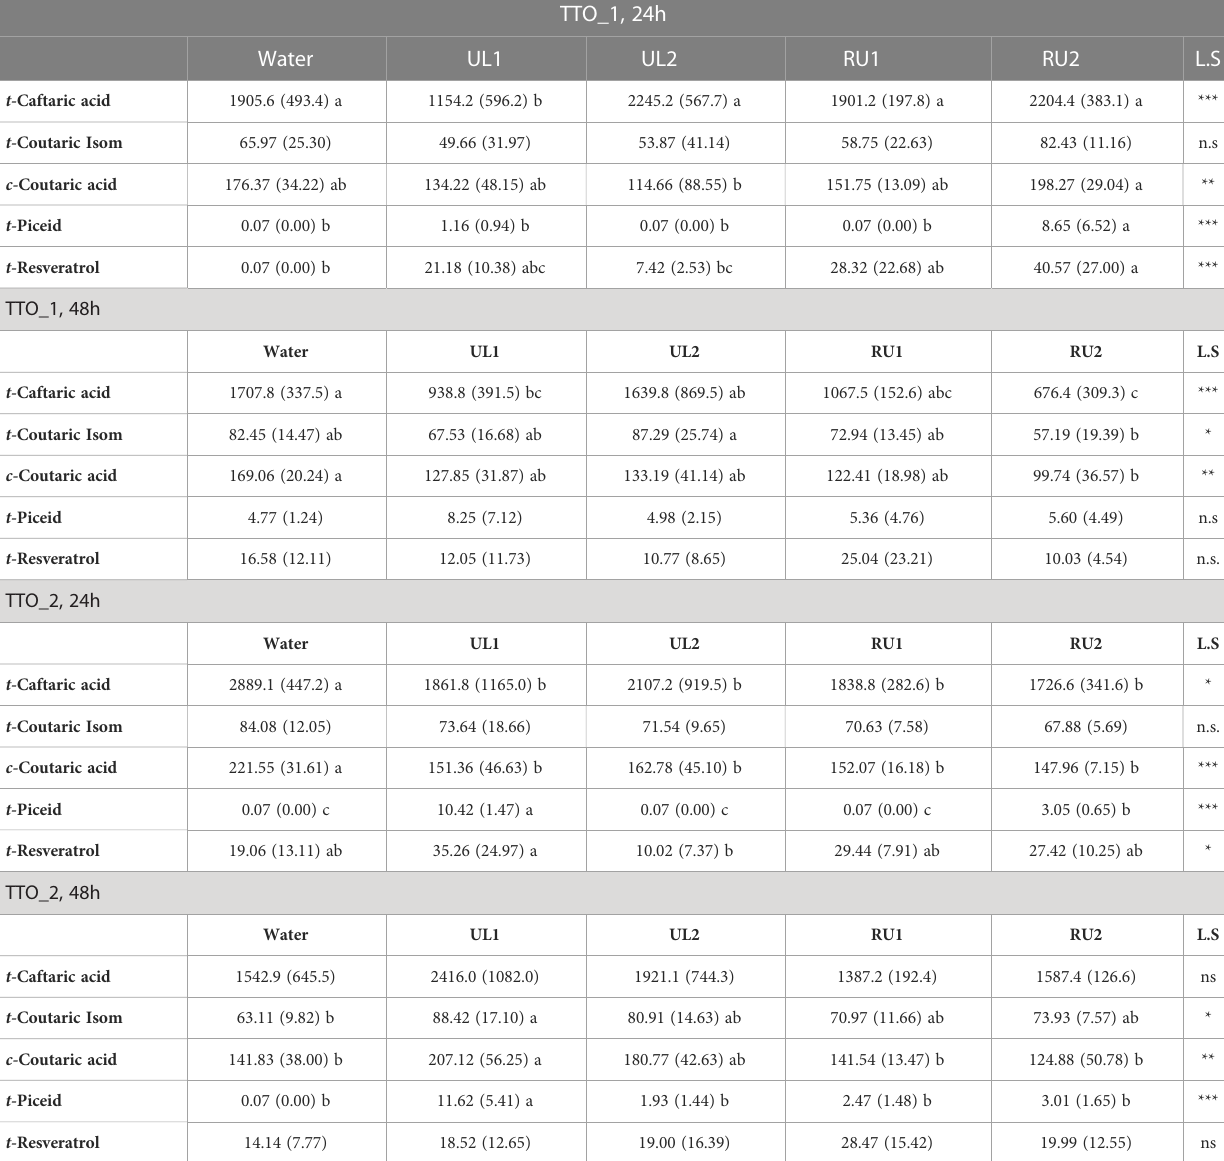
TABLE 3 Polyphenol content (mg/kg DW) in treated leaves at different sampling